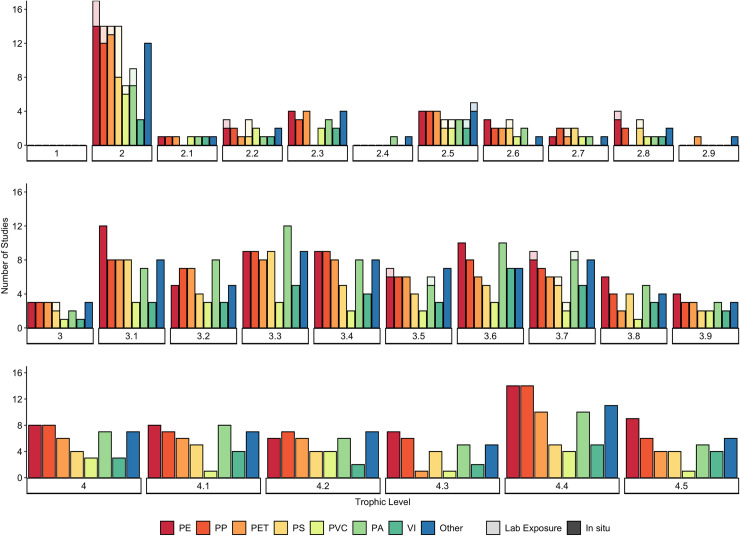
Frequency of microplastic (MP) polymer types confirmed in studies on marine species collected in situ and exposed in laboratory experiments.Data has been organised by trophic level, which are grouped into to a single decimal place, i.e. level 4.2 includes 4.21 to 4.29. Microplastic polymers include those found in organisms collected from field samples (n = 87 studies; dark shaded on bottom) or used in laboratory experiments investigating MP uptake, including those focused on trophic transfer (n = 22 studies; light shaded on top). Note that not all studies confirmed or reported MP polymer types. Details regarding the number and percentage of studies for each trophic level have been provided in S8 Table in S1 File. ‘Other’ includes less frequently found polymers such as: PAN, PMMA, CP, PC, ABS, EVA, PVA, PUR, PTFE, ASA, acrylic, alkyd and epoxy. Some varieties of polymers have been grouped together (i.e. PE includes HDPE, MDPE and LDPE; PET includes PET and PES).